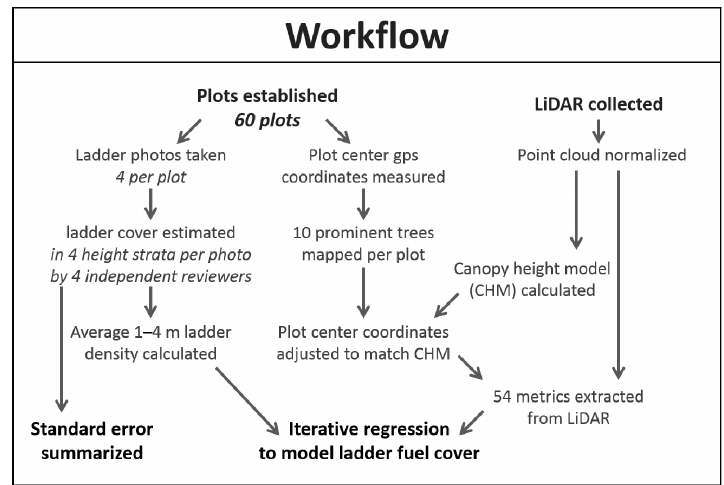
Figure 7. Our detailed workflow illustrates how we used plots and LiDAR to answer our key questions.